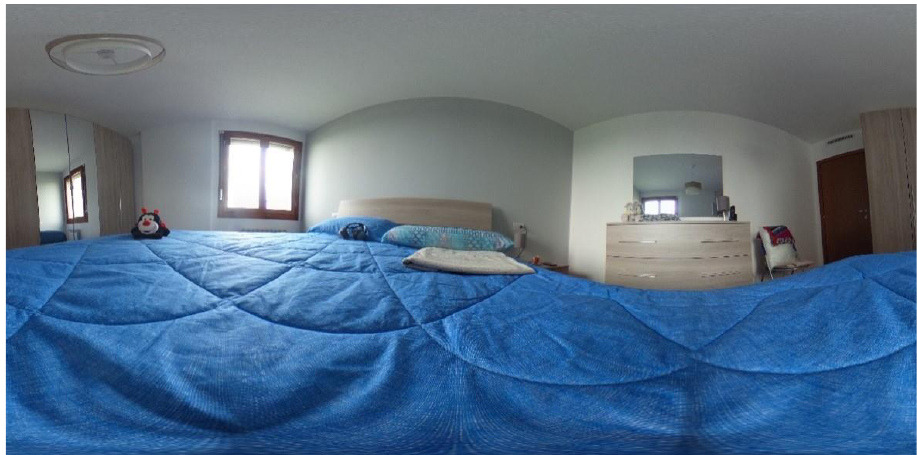
Figure 1. A representation of a 360° environment that participants see in the headset (here, the image is represented in anamorphic format).